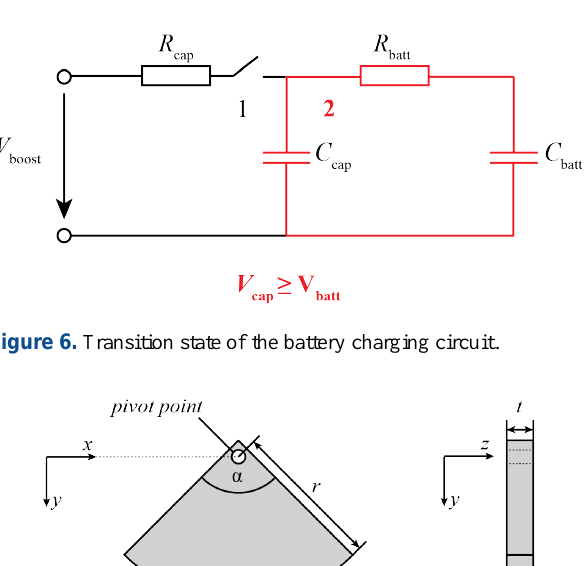
Figure 5. Initial state of the battery charging circuit.